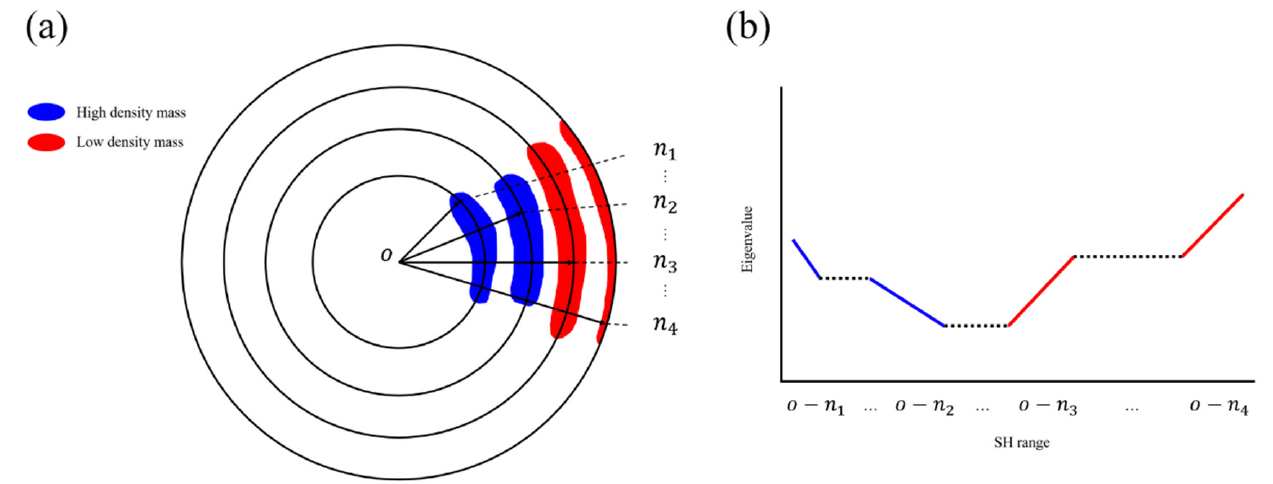
Figure 3. Concept of the method devised in our study. In the gravity model of spherical harmonics (SH), as the degree and order increase, a shallow short wavelength is expressed. Calculations by specifying a degree and order range can indicate the gravity at a specific depth level. It is easy to find out what information is added at a shallower depth by increasing the degree and order range at regular intervals. In arbitrary SH degrees n 1–4 , if a mass exists in a specific degree and order (correspond to depth), with a structure similar to that shown in ( a ), it can be expressed as ( b ) through eigenvalues of gravity gradient tensor. In the range of degree and order corresponding to high density mass, eigenvalues indicated a negative trend, and in the low-density mass section, eigenvalues indicated a positive trend.